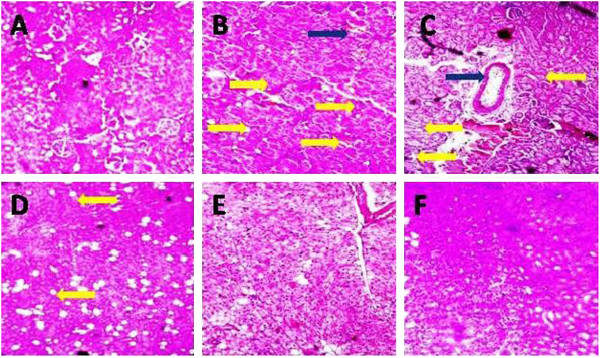
Effect of umbelliferone β-D-galactopyranoside (UFG) on histopathology study of kidney in different groups of rat: (A) Normal control: Normal control group rat histopathology shown normal size of glomerulus (B) Diabetic control: Diabetic control rat histopathology shown inflammatory cell in blood vessels (blue arrow) and deposition of fats (yellow arrow) (C) UFG I (10 mg/kg): Tested drug UFG (10 mg/kg) treated group rat histopathology shown inflammation in blood vessels (brown arrow) and fat deposition (yellow arrow) (D) UFG II (20 mg/kg): Dose UFG (20 mg/kg) treated group rat histopathology shown only fat deposition (yellow arrow) no inflammatory blood cells. (E) UFG III (40 mg/kg): Treatment with dose UFG (40 mg/kg) group rat histopathology shown kidney histopathology like the glibenclamide treated group (F) Glibenclamide (10 mg/kg): Histopathology of Glibenclamide treated group rat shown the normal kidney. The samples were obtained from the same liver anatomical regions. For each group, 6 rats were examined and 80 pictures were taken. The above picture for each group was chosen randomly from the 80 pictures in this group. Original magnification, 10 × .